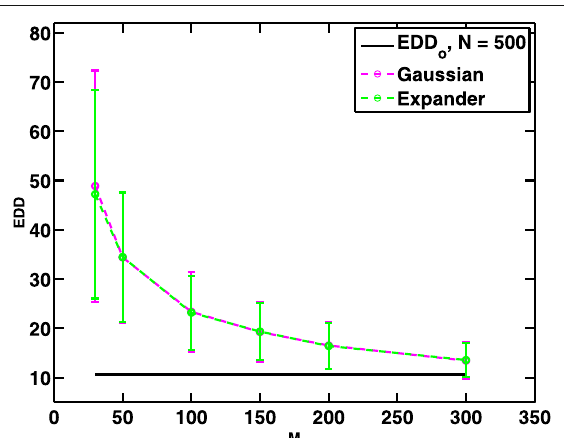
Fig. 7 Comparison of EDDs for A being a Gaussian random matrix versus an expander graph when [ μ ] i ’s are i.i.d. generated from [ − 3,3]